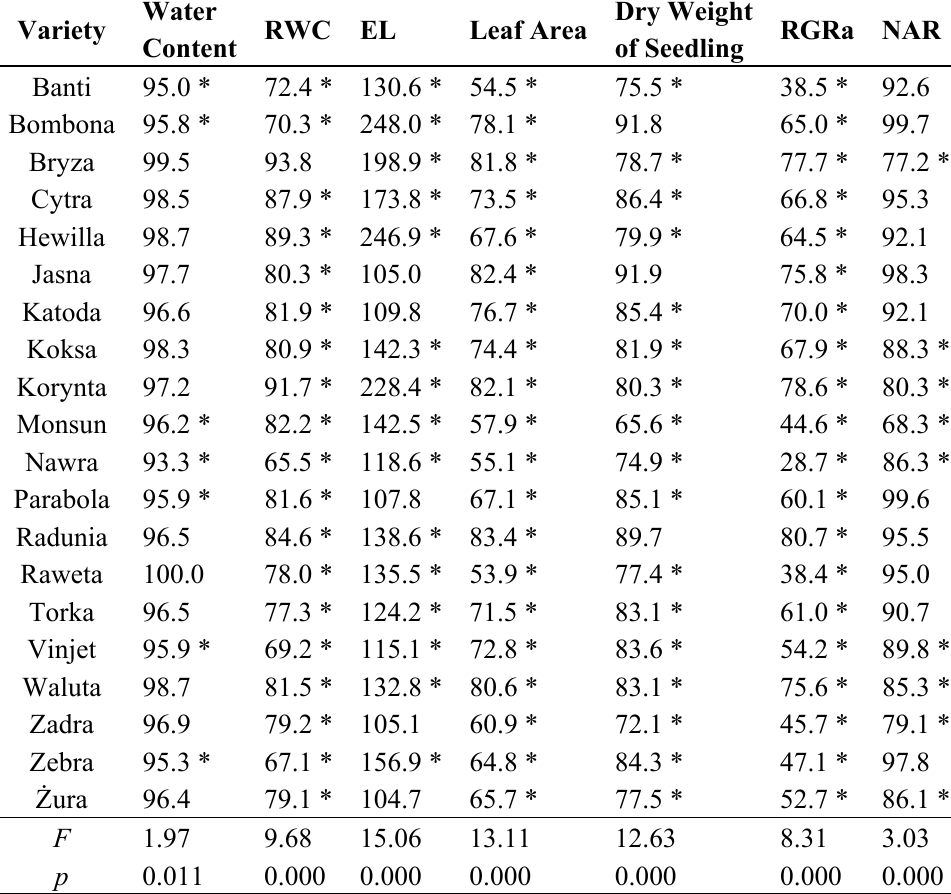
Table 2. Values of stress index (as percentage of control) water content, relative water content (RWC), electrolyte leakage (EL) and growth parameters of seedling (leaf area, dry weight of seedling, RGRa, NAR) of 20 wheat varieties after 10 days of drought